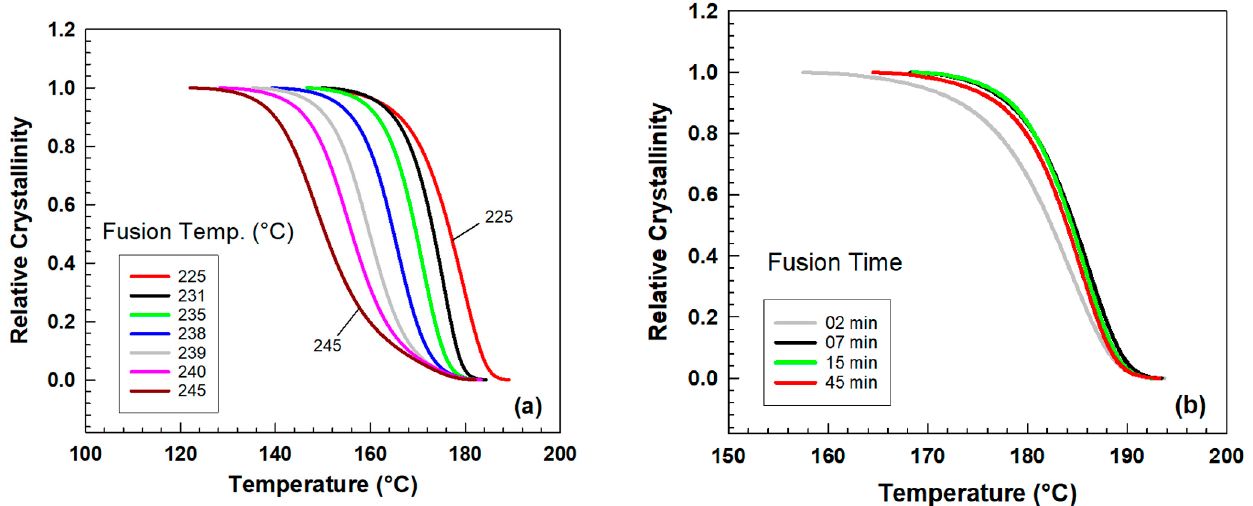
Figure 3. Relative degree of crystallinity as a function of temperature for PA6 ( a ) fusion temperature from 225 °C to 245 °C at 25 °C/min ( b ) fusion time 2, 7, 15, and 45 min at constant T f = 239